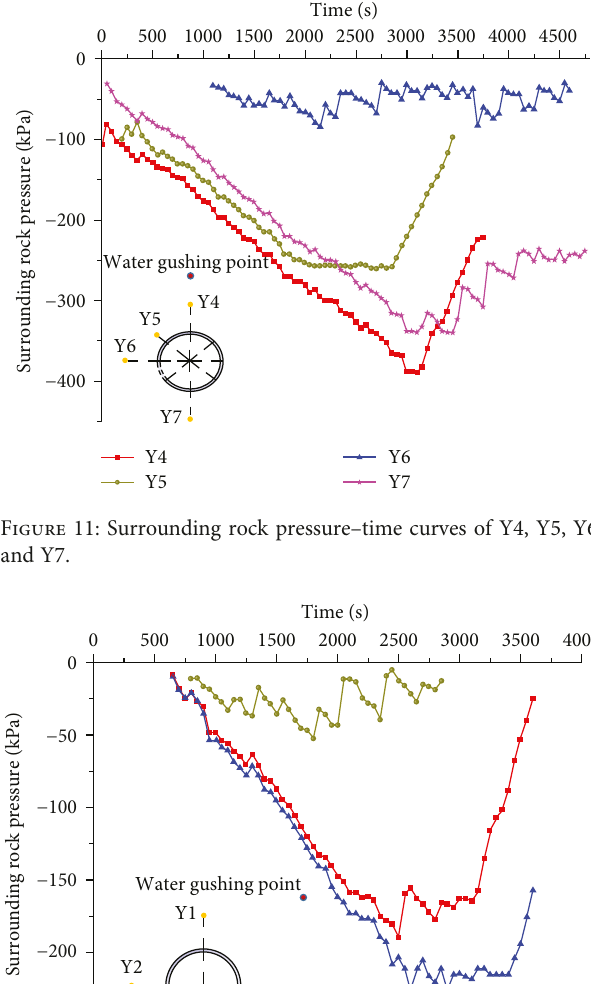
Figure 10: Pore water pressure – time curves of S1, S2, and S3.